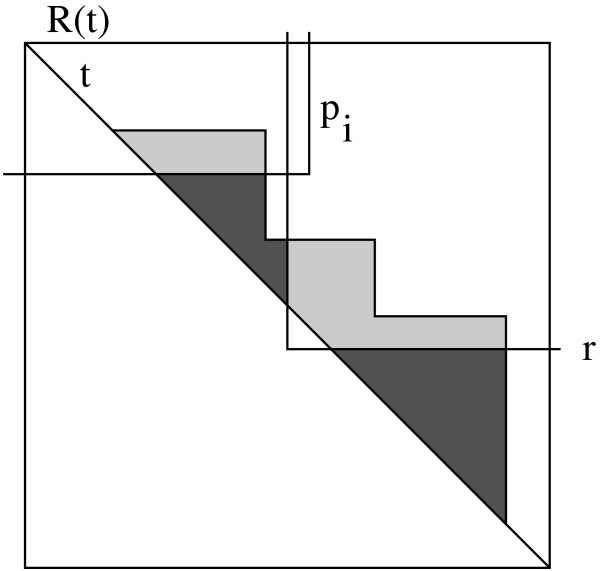
The basic intersection staircase shown in grey must be refined since there are rectangles like Pi ∈ Pr(t) and r ∈ Rr(t) which have not been considered before in the runs for t' and which reduce the basic intersection staircase such that a lower staircase shown in darkgrey remains. Hence for the computation of the maximal cliques regarding t we have to reduce the area of the upper half only by the refined staircase.